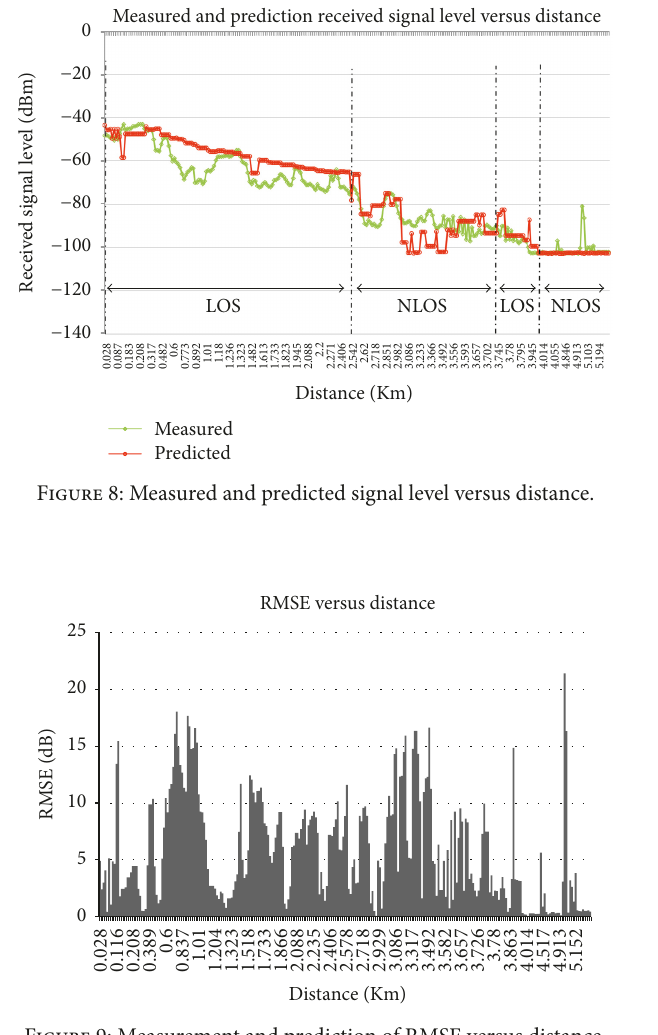
Figure 9: Measurement and prediction of RMSE versus distance.